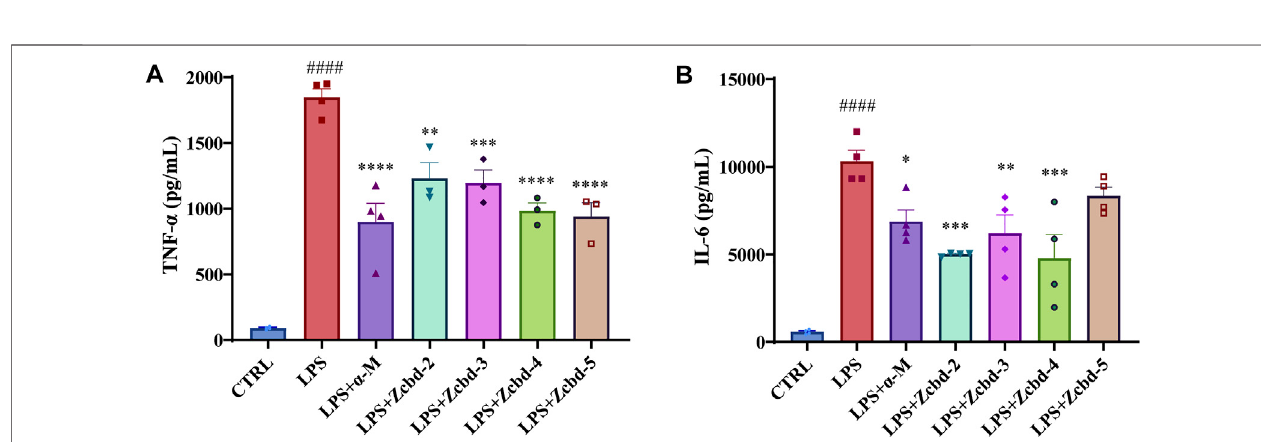
FIGURE 4| α -M and its analogues suppressed LPS-induced production ofpro-in fl ammatory cytokines in microglia BV-2 cells. BV-2 cells were pre-treated with α - M or its analogues for 2 h prior to stimulation with LPS (100 ng/ml) for another 24 h. Then the protein levels of (A) tumour necrosis factor- α (TNF- α ) and (B) interleukin-6 (IL-6) were measured by ELISA in LPS-stimulated BV-2. All data represent mean ± SEM from at least 3 independent experiments. p p < 0.05, pp p < 0.01, ppp p < 0.001, pppp p < 0.0001 compared to the LPS-stimulated group (LPS); #### p < 0.0001 compared to the control group (CTRL).